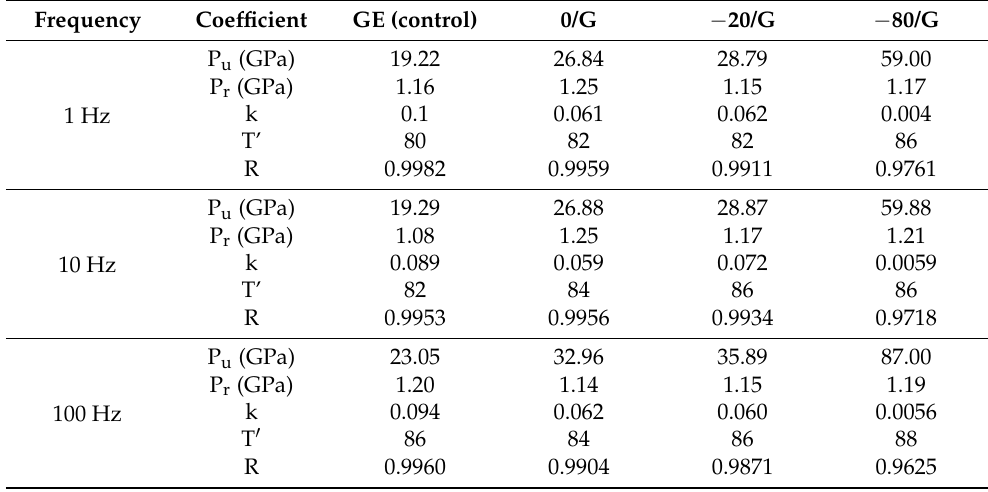
Figure 13. Comparison of measured and empirical models for − 80/G laminates at frequencies of 1 Hz ( a ), 10 Hz ( b ) and 100 Hz ( c ). Table 7. Coefficients based on Gibson et al. [30] curve-fitting on experimental results